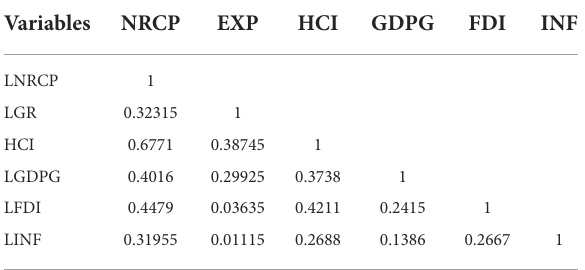
TABLE 2 Matrix of correlations.